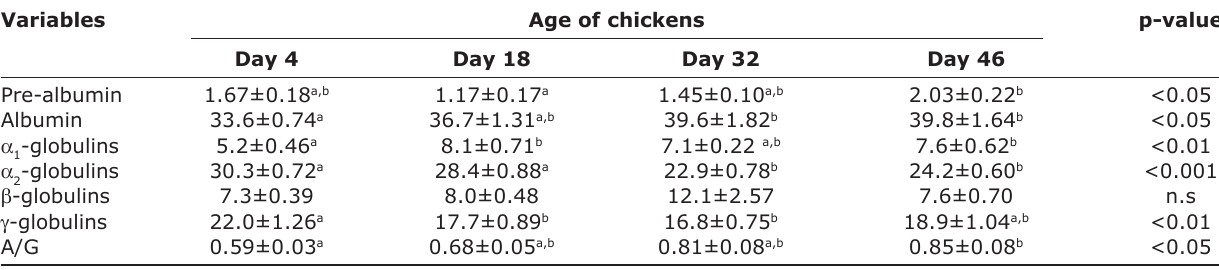
Table-2: Changes in the relative concentrations of serum protein fractions (%) and albumin/globulin ratio (A/G) in broiler chickens during the fattening period (mean±SE). Variables